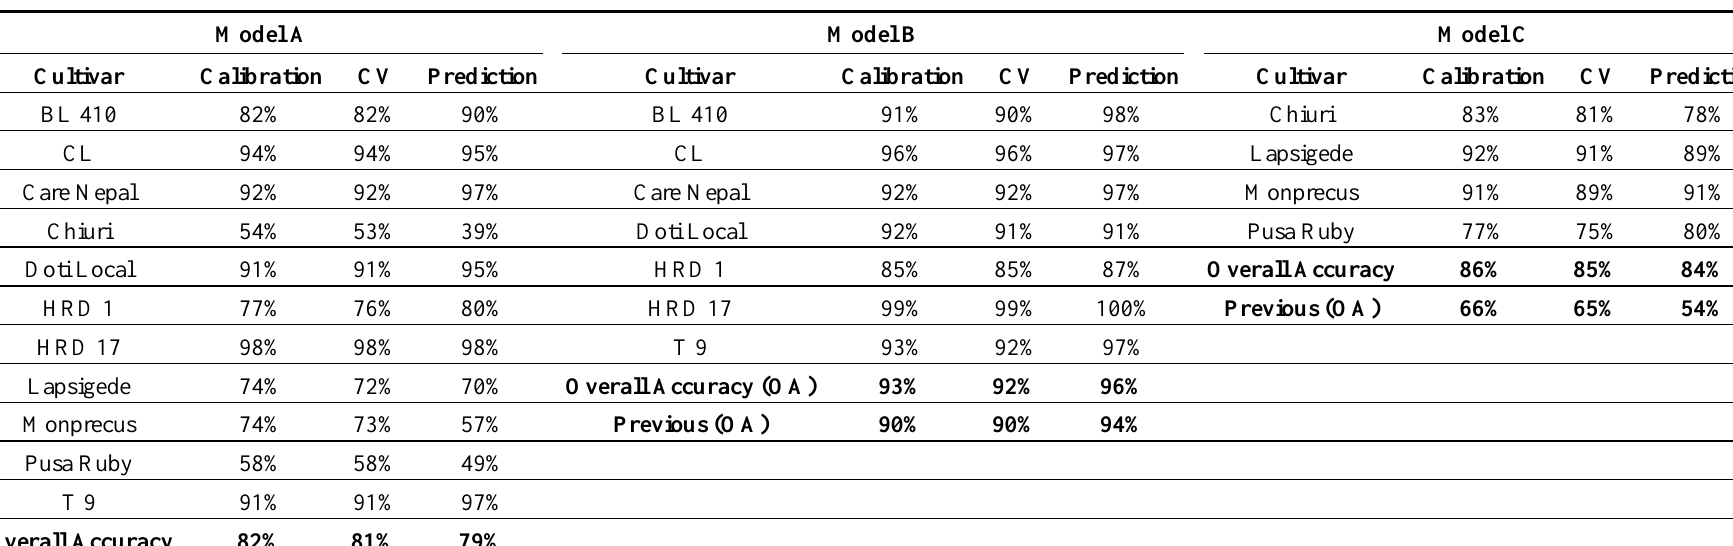
Table 4. PLSDA classification of eleven tomato cultivars—Model A) includes all the cultivars, stepwise PLS-DA classification—Model B) includes cultivars with higher sensitivity and Model C) includes cultivars with poor sensitivity from Model A. Previous Overall accuracy (OA) was calculated using the number of correct classifications in selected classes divided by the total number of seed samples of selected classes of Model A.